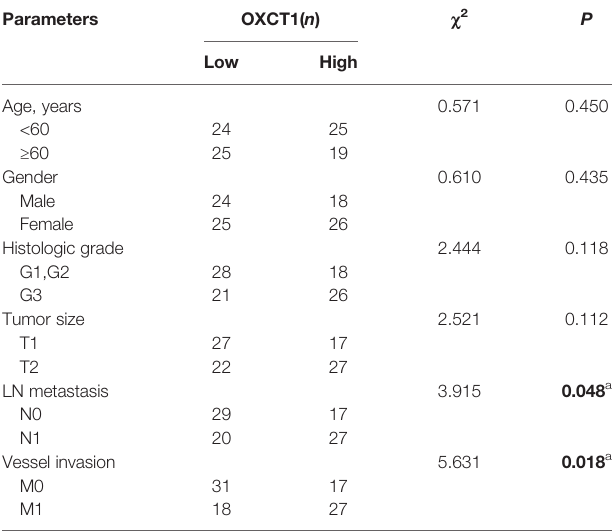
TABLE 1 | Correlation of OXCT1 expression to clinicopathologic features in PDAC. Parameters